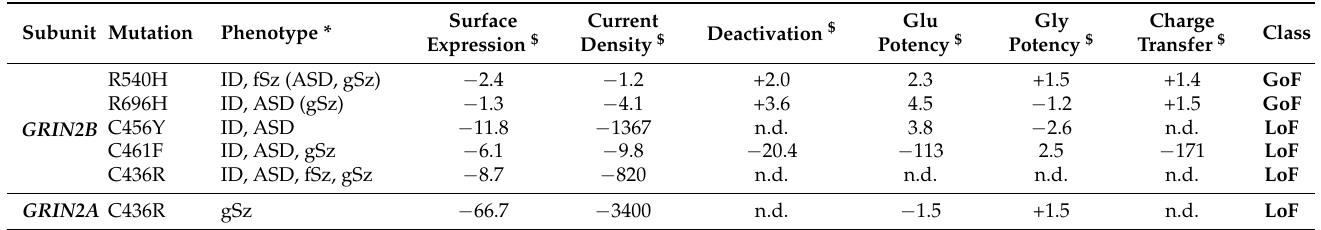
oocytes or HEK cells)